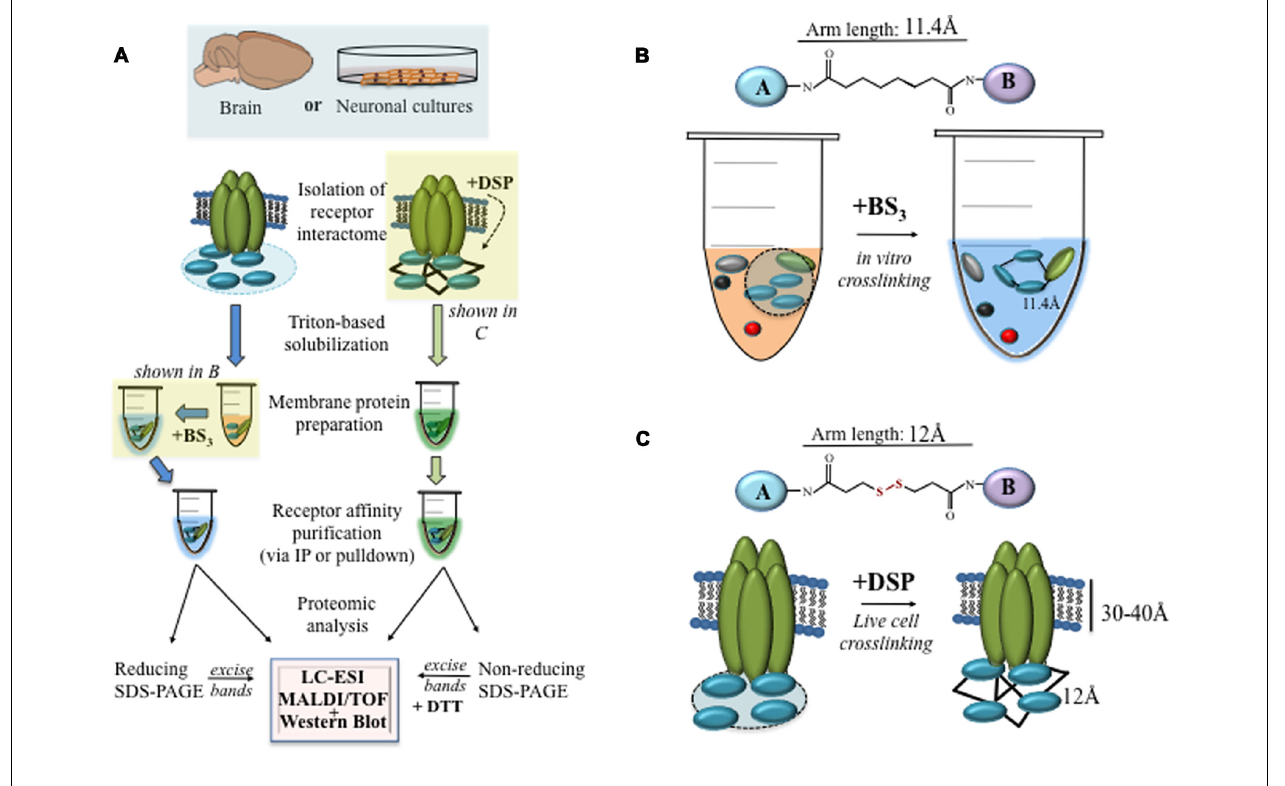
spacer arm. (B) The irreversible crosslinker BS 3 is effective for crosslinking nAChR interactomes after membrane protein solubilization withTriton-X. (C) The membrane permeable crosslinker DSP, on the other hand, can be used to crosslink receptors and their interacting proteins in living